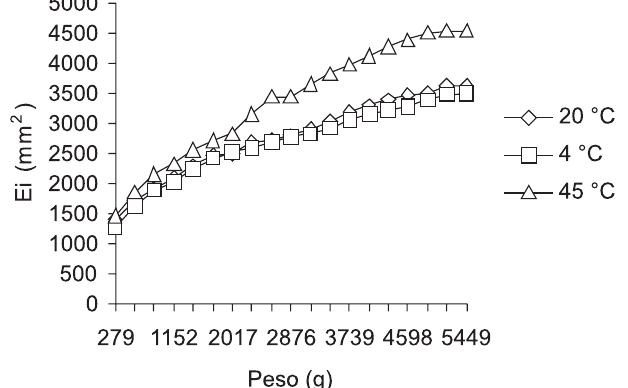
FIGURA 4 – Espalhabilidade (Ei) da EBHT (60 dias) nas diferentes condições de armazenamento em relação ao peso adicionado (n=3). não houve variação significativa nesses valores, ao longo dos 60 dias de análise (Figura 5). Por ter apresentado separação de fases não foi possível a análise da mesma a 45 ºC.